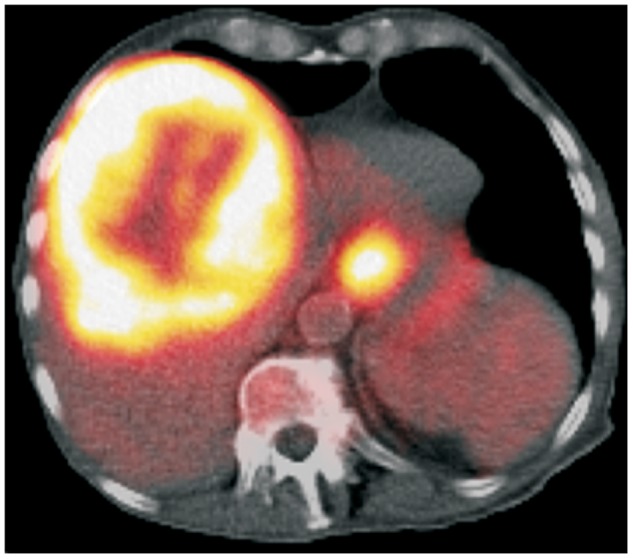
Positron emission/computed tomography scan reveals a large, intense metabolically active, low-density lesion with central photopenic area in the liver and an intense metabolically active area at the gastroesophageal junction.